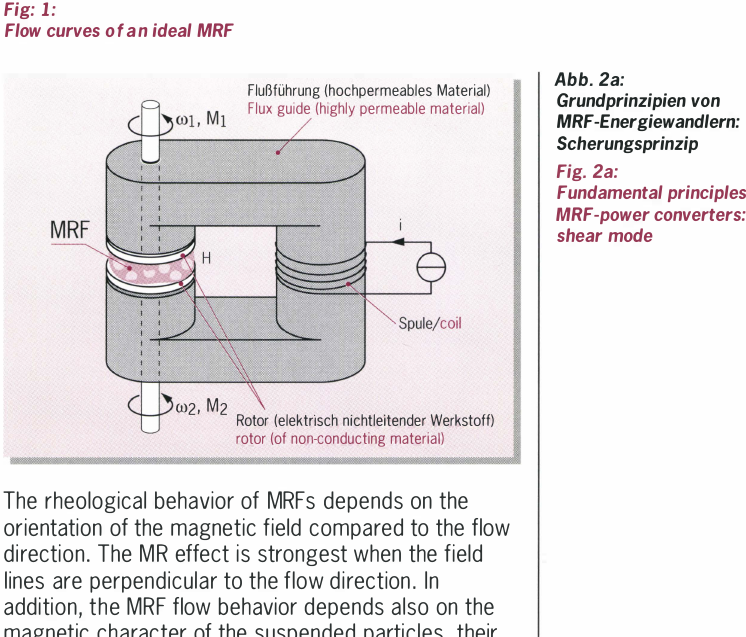
Fig: 1: Flow curves of an ideal MRF